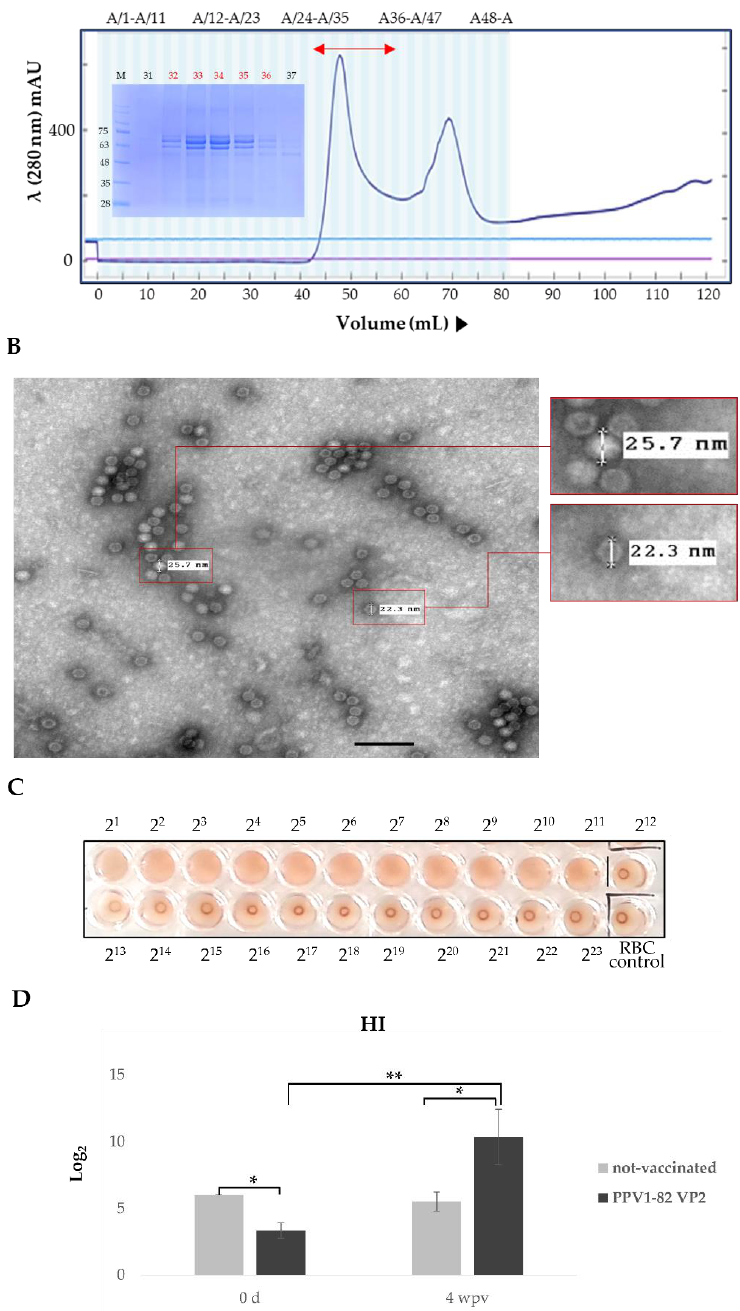
Figure 2. Plant-produced PPV1-82 VP2 protein purification and immunogenicity. ( A ) The PPV1-82 VP2 size-exclusion chromatography trace and an SDS-PAGE gel image of the collected fractions. The bidirectional red arrow indicates the elution fractions (32–36) that the purified PPV1-82 VP2 protein was collected from. ( B ) Transmission electron microscopy image of virus-like particles formed using the purified PPV1-82 VP2 protein (scale bar = 100 nm, HV = 75.0 kV, direct magnification: 100,000×). ( C ) HA results, sedimentary red blood cells represented non-agglutination. ( D ) Results from the HI assay performed on samples from three piglets vaccinated with PPV1-82 VP2; wpv, weeks postvaccination; * p < 0.05; ** p < 0.01.